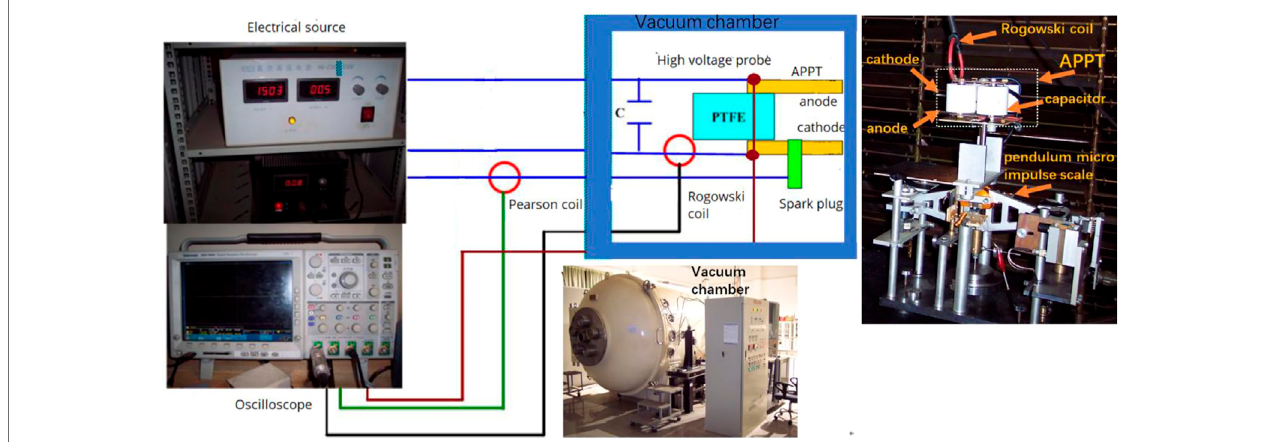
FIGURE 1 | Schematic of the experimental set-up.